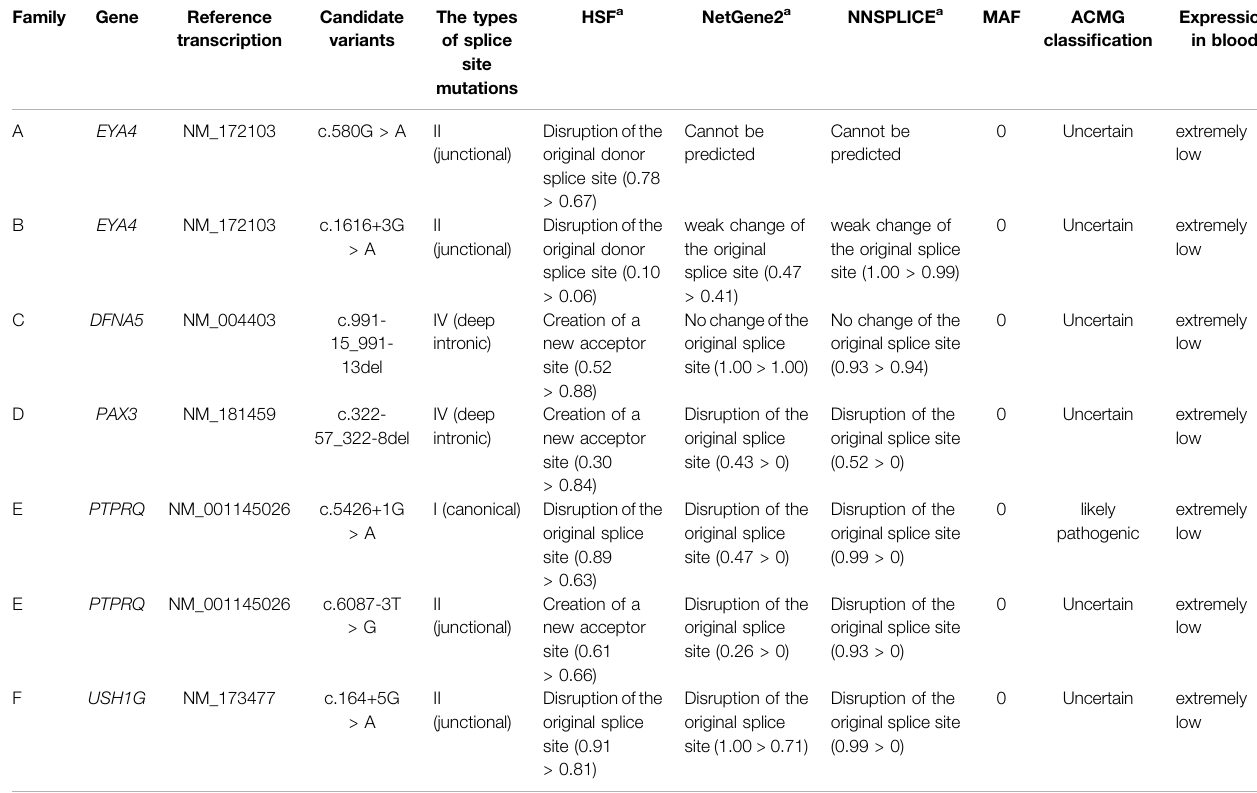
TABLE 2 | Summary and bioinformatic analysis of the pathogenic variants identi fi ed in Families A-F.